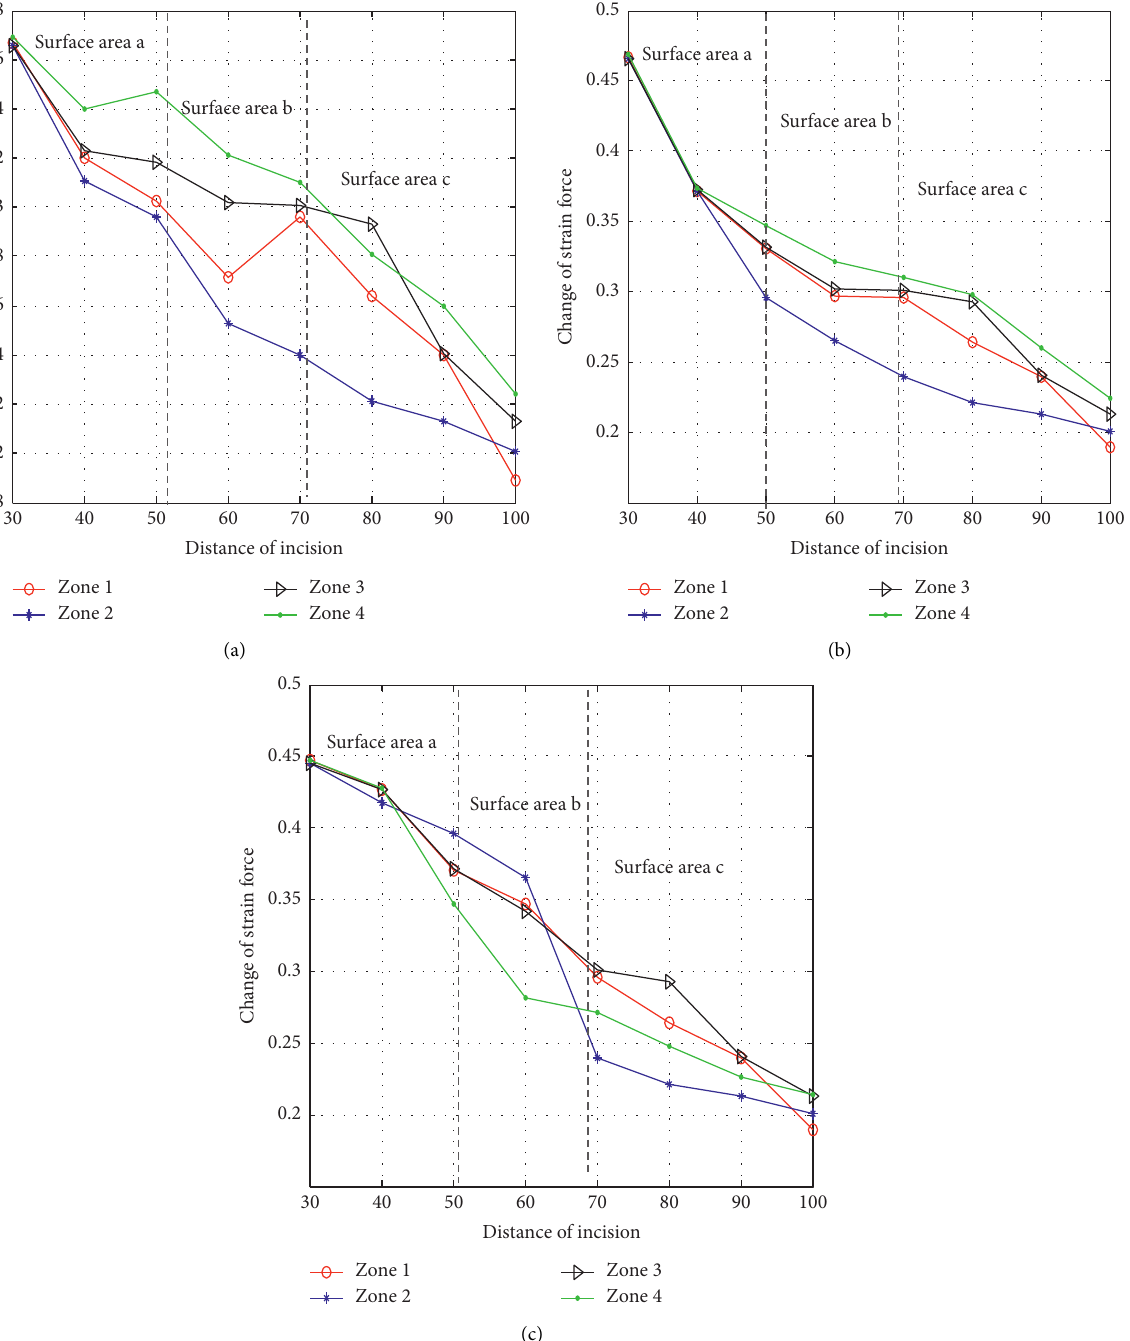
Figure 7: Variation curve of surface deformation corresponding to different heights of crack zone on site surface (60cm). (a) Division 1. (b) Division 2. (c) Division